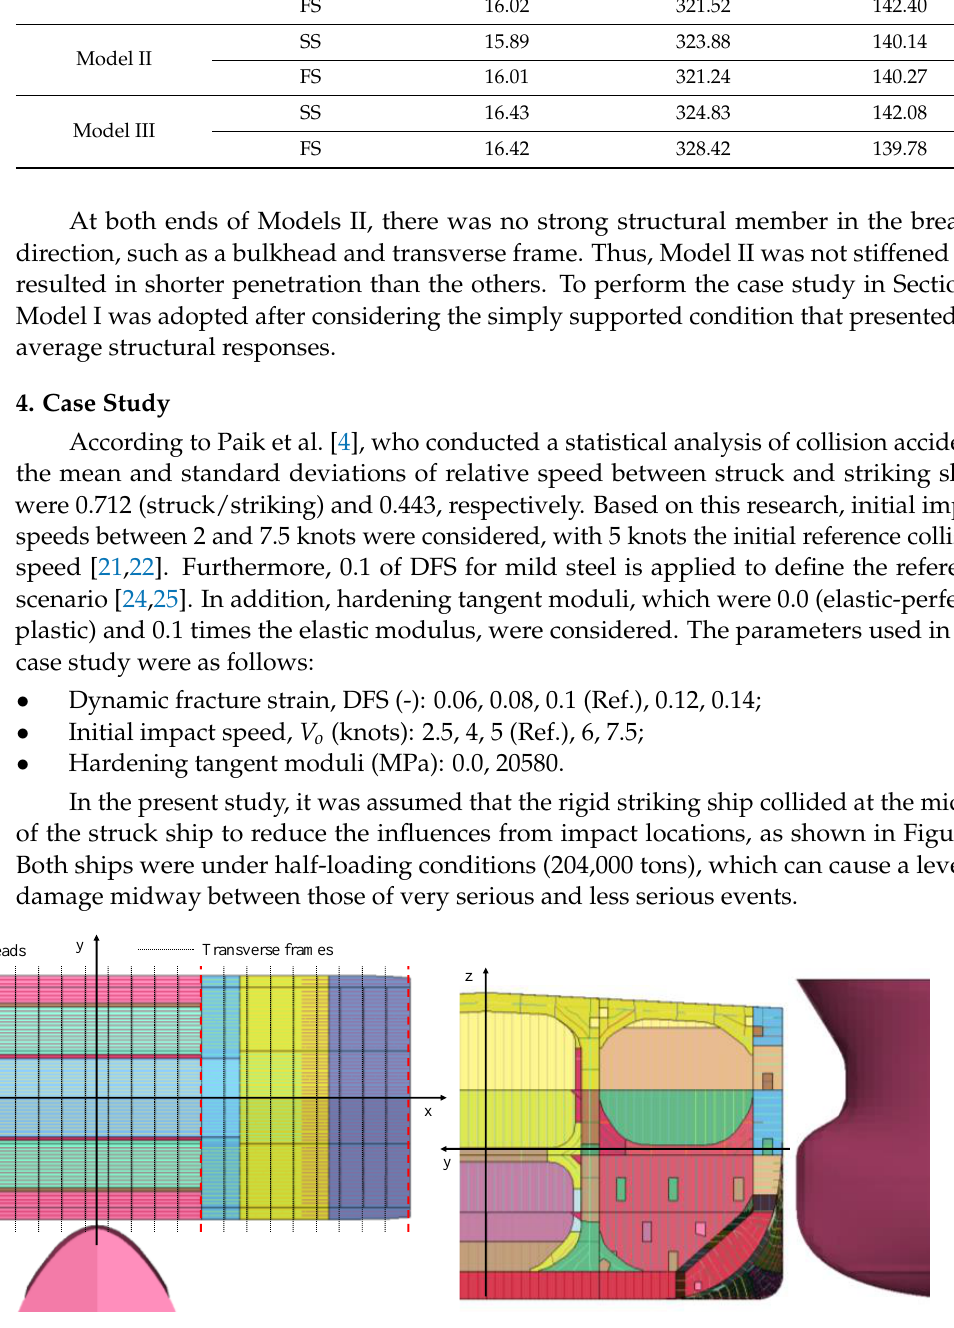
Figure 6. Collision location.